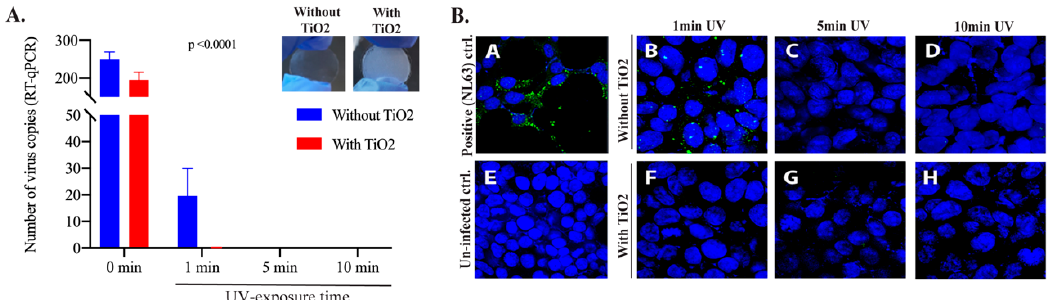
Figure 3. TiO 2 nanoparticles enhanced HCoV-NL63 inactivation with no live virus in 1 min UV exposure. ( A ) HCoV-NL63 virus aliquot (100 μ L) was placed on glass coverslips treated with or without TiO 2 and exposed to UV light for 1, 5- and 10-min. Post-UV treatment, HCoV-NL63 was collected for viral RNA extraction. Intact viral copies were calculated based on the standard curve generated above. On top, coverslips without and with TNP coatings to show the level of opacity following TiO 2 coatings. ( B ). Post-UV treatment, HCoV-NL63 virus was collected and subjected to the infection of HEK293L monolayer. Viral protein, indicator of virus infectivity and replication, was detected by immune localization through IFA (green fluorescent dots). A) NL63 infection (positive control); B) 1 min UV light exposure without TiO 2 ; C) 5 min UV light exposure without TiO 2 ; D) 10 min UV light exposure without TiO 2 ; E) uninfected control (negative control); F) 1 min UV light exposure with TiO 2 ; G) 5 min UV light exposure with TiO 2 ; H) 10 min UV light exposure with TiO 2